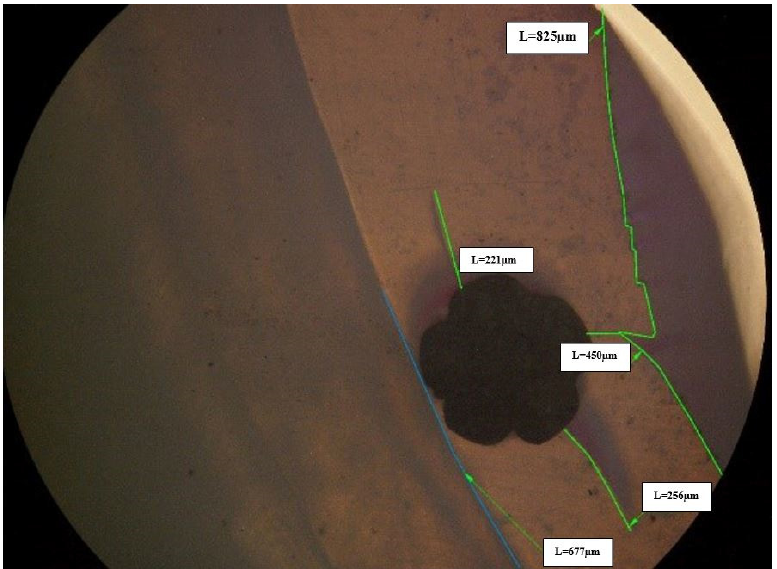
Figure 4. Stereomicroscopy at a magnification of 40 times of a 1 mm section of a composite specimen displaying the retainer-incorporating composite on the enamel surface.